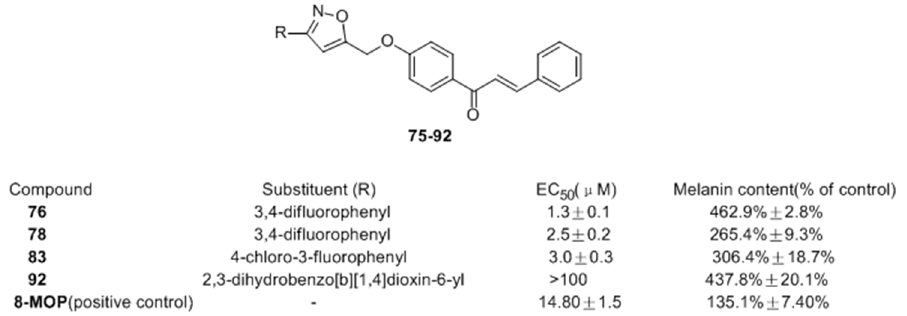
Figure 10. Structures of the chalcones derivatives bearing isoxazole